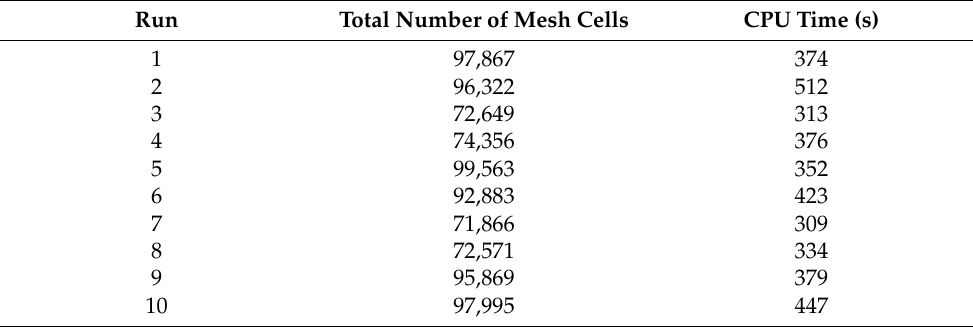
Table 7. Representation of best combinations of global and local meshes for each run, number of mesh cells, and time of central processing unit (CPU) generated by these mesh combinations for the geometry with lateral air inlet and